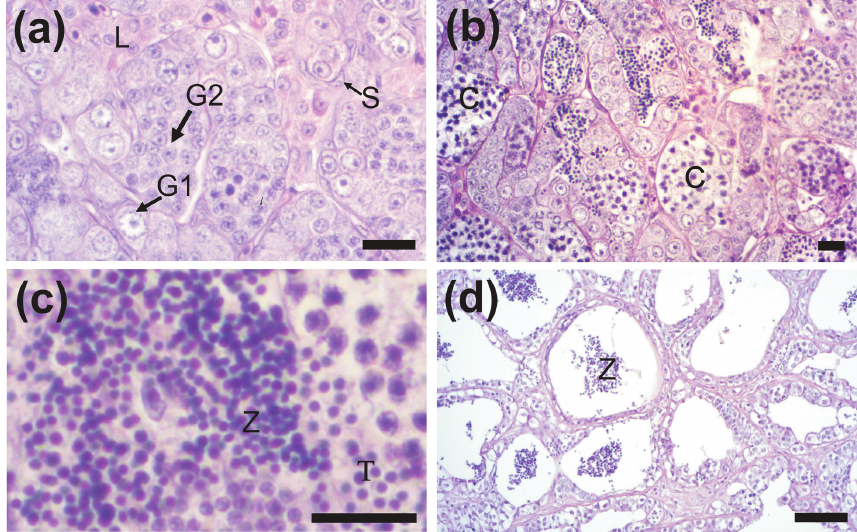
Figure 5 - Histological sections of H. francisci testes stained with hematoxylin-eosin. (a) primary spermatogonia (G1), secondary spermatogonia (G2), Leydig cells (L) and Sertoli cell (S). (b) spermatocytes (C). (c) spermatids (T) and spermatozoa (Z). (d) spermatozoa (Z). Bars: a-c) 20 μm and d) 90 μm.